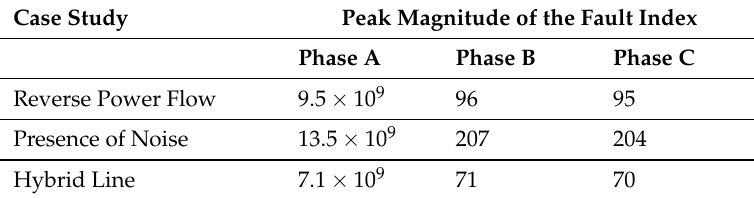
Table 2. F-index peak